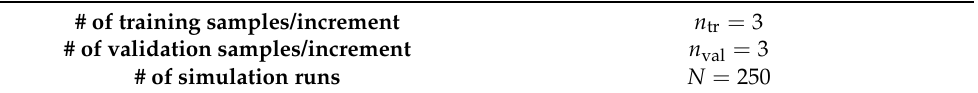
Table 5. Main parameters in the learning process. # of training samples/increment n tr = 3 # of validation samples/increment n val = 3 # of simulation